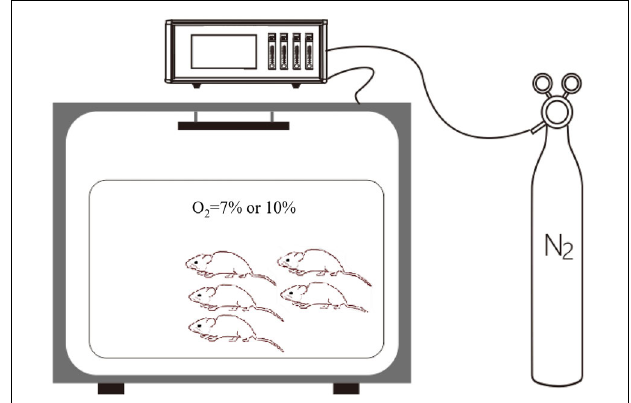
FIGURE 2 | The normobaric hypoxic chamber. A proportional integral differential controller is used for the regulation of pressure and for the control of the solenoid valve. The oxygen concentration was regulated by using an oxygen controller with a nitrogen generator. The oxygen concentration range and accuracy were 0–25% and 0.1%,